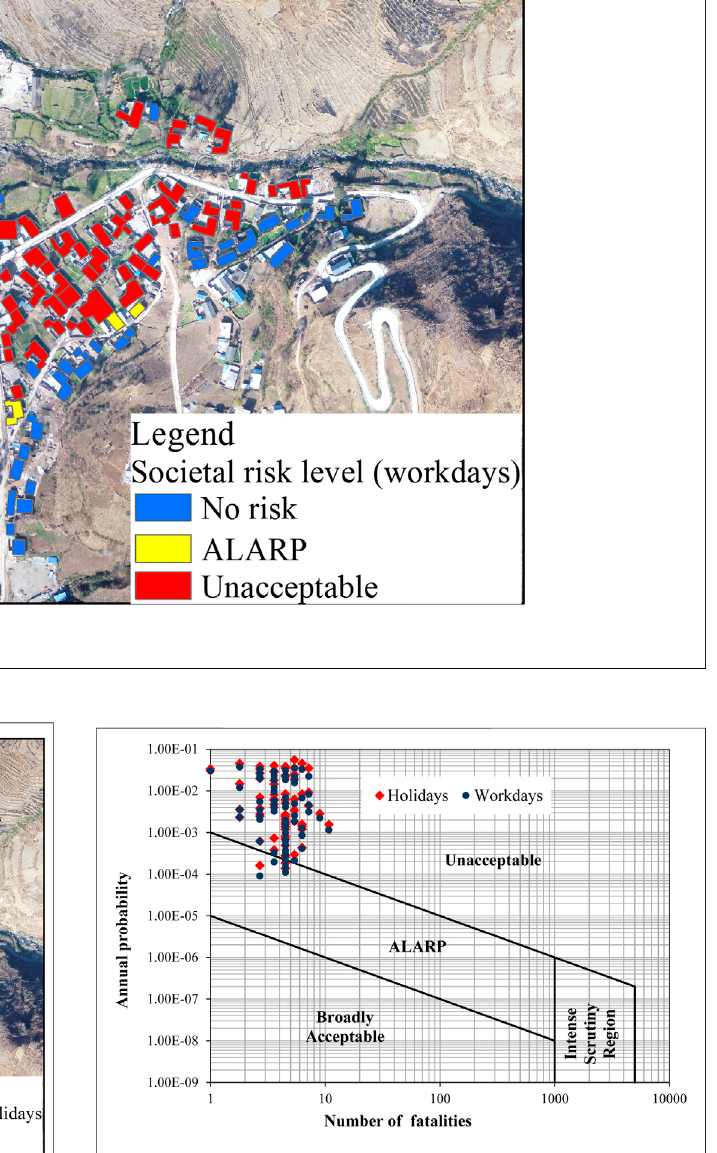
FIGURE 10 | F – N curvesfor the debris fl ow societal risk on holidays and workdays in Luomo village.